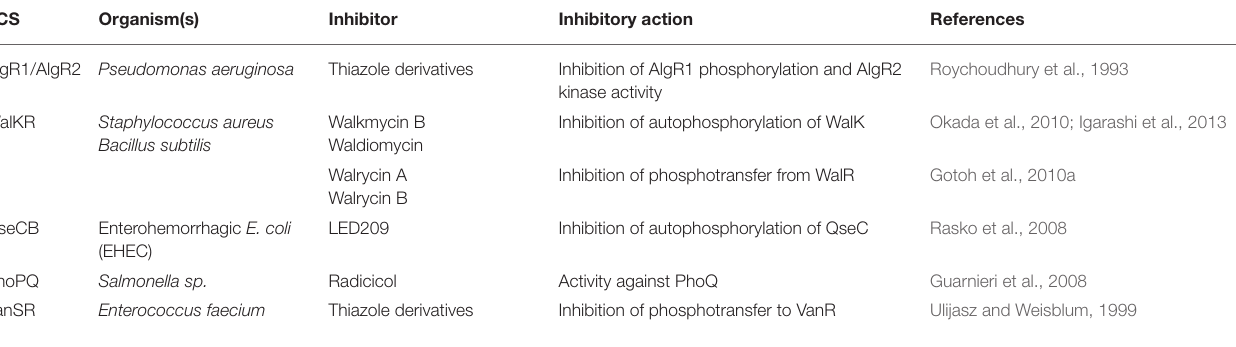
TABLE 2 | A brief summary of the examples of using TCS inhibitors as a therapeutic option in bacterial pathogens other than A. baumannii